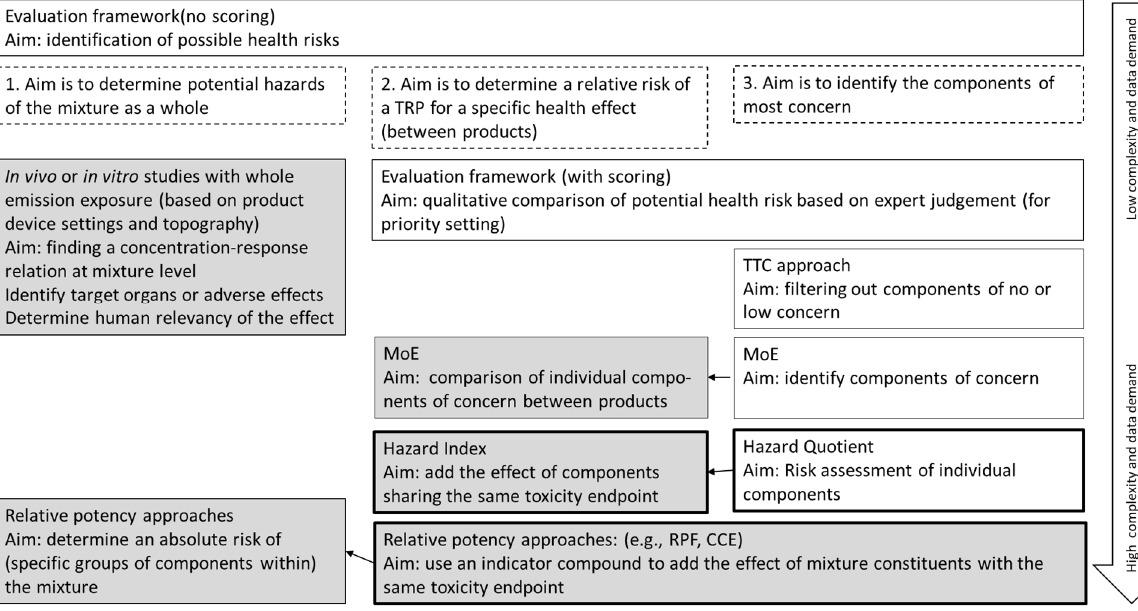
Figure 1. Overview of risk assessment methods for health risk assessment of TRPs. The choice of the method is dependent on the aim. Dashed boxes: the three different aims of the risk assessment methods. The methods that can be used for this aim are in the same column. White boxes: Methods resulting in an assessment for the individual compounds in the emission. Grey boxes: methods resulting in an assessment for the mixture of components. Interaction between components is not considered, except for experimental studies with whole emission. All methods, except experimental studies with whole smoke, are dependent on the available data on emission composition and on hazard for individual components. Black-lined boxes: these methods allow quantification of risk of single components. The arrows between boxes indicate a follow-up of that method; for example, the MoE approach first needs to be applied to identify components of concern before it can be used to compare these components between products. The arrow on the right indicates the complexity and data requirements of the methods.